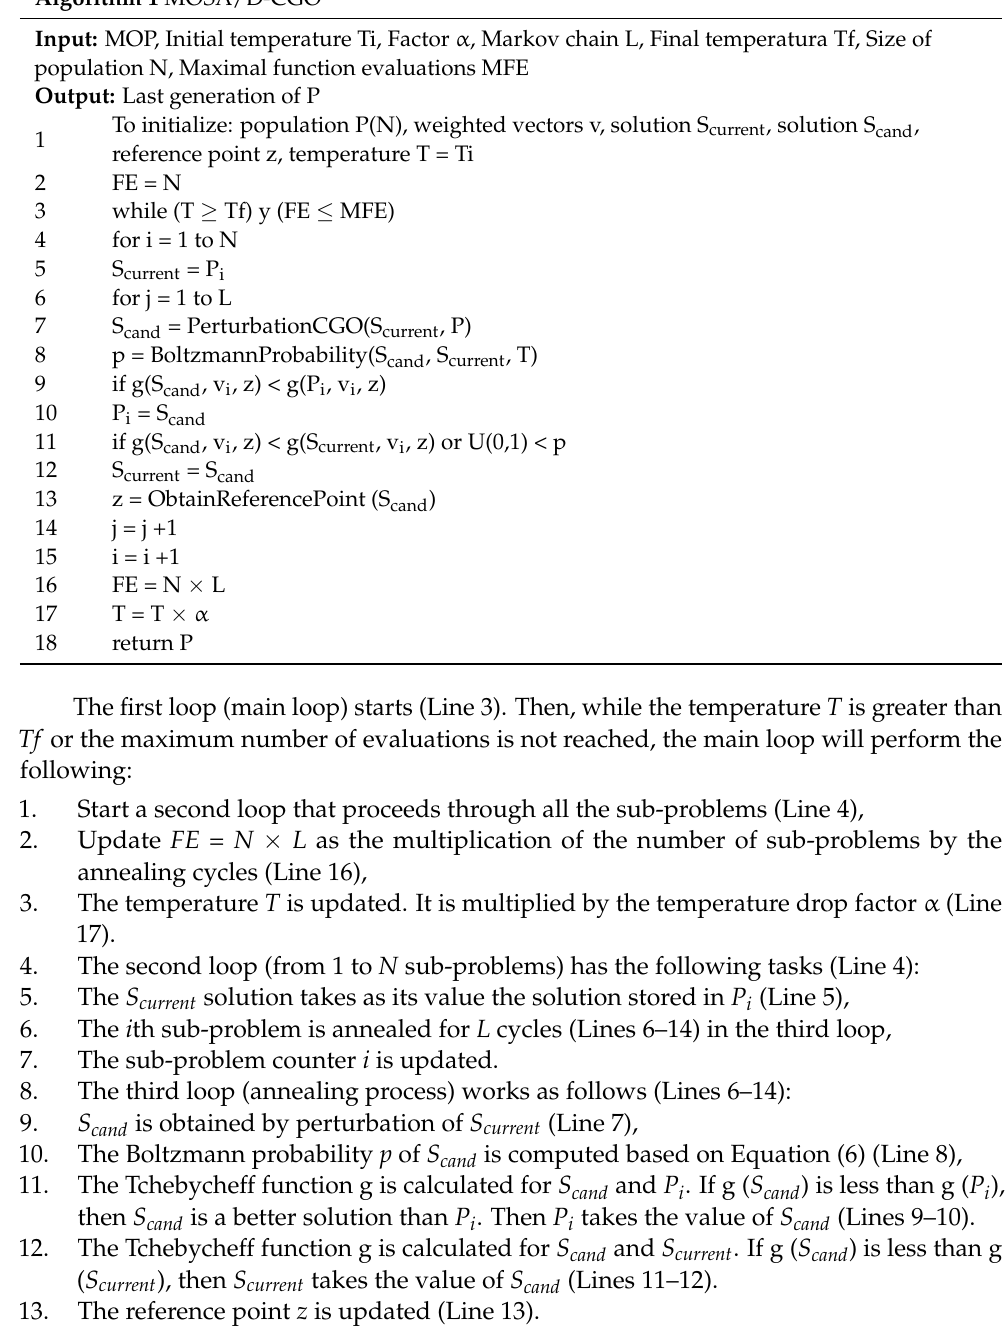
Algorithm 1 has three loops: the first, second, and third (Lines 3, 4, and 6, respectively). Algorithm 1